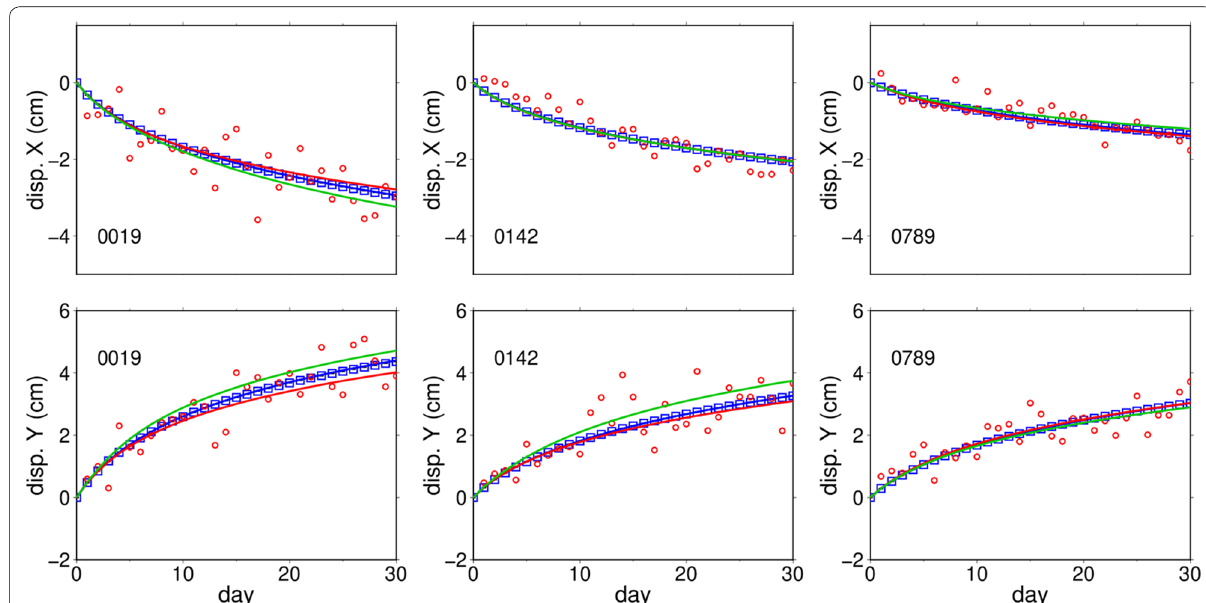
Fig. 3 Examples of postseismic time series in the numerical experiments. Blue squares and red circles indicate the synthetic data in Exps. 1 and 2. Green, blue, and red lines are the theoretical time series calculated by using the first-guess and optimum frictional parameters in Exp. 1 and 2, respectively. The locations of the GNSS stations are shown in Fig. 1